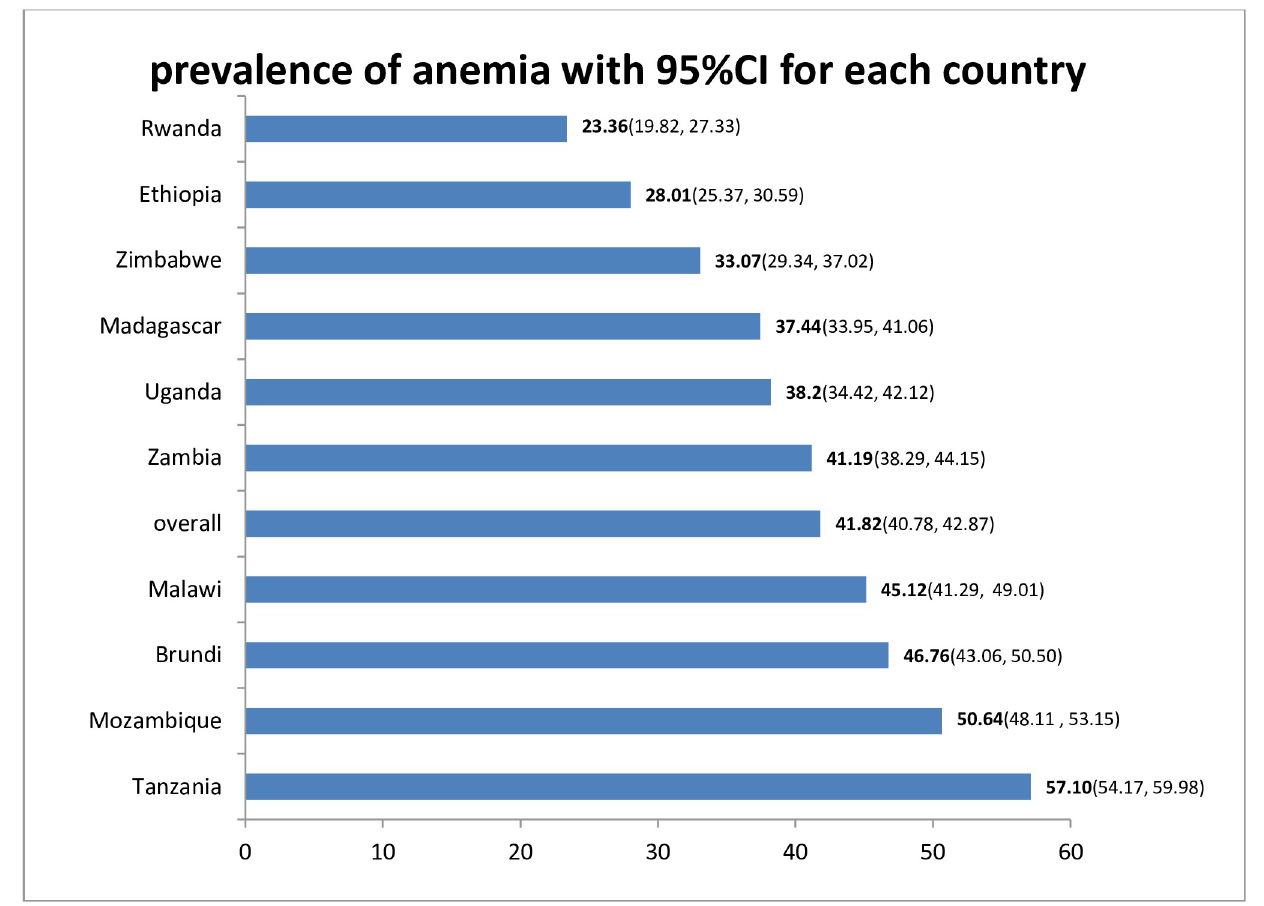
Fig 1. Prevalence of anemia among pregnant women in East Africa, 2020.